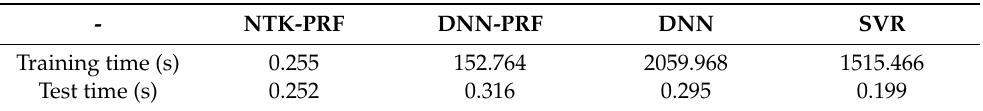
Table 5. Training and test time of different